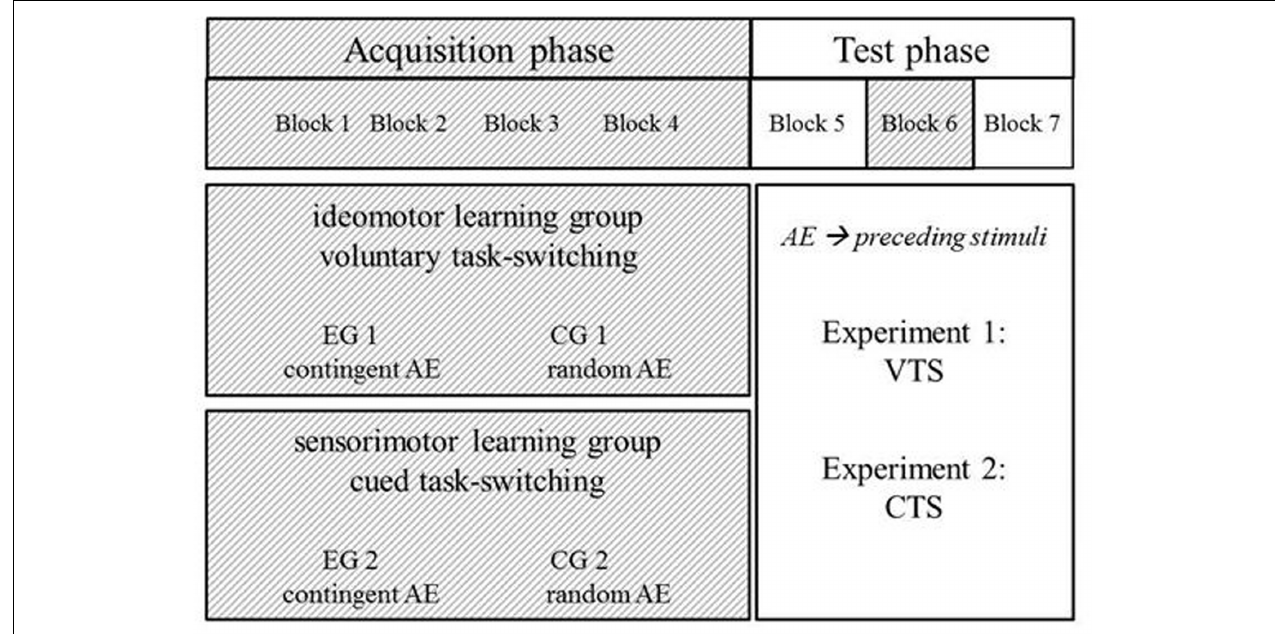
FIGURE 2 | Experimental design for both experiments: CG 1 and CG 2 – control groups, EG 1 and EG 2 – experimental groups. 1 stands for voluntary task-switching (VTS), 2 for cued task-switching (CTS), AE for action effects. In Experiment 1, the test phase was voluntary task switching, in Experiment 2, the test phase was cued task switching. In the test phase, action effects became preceding effects (practiced